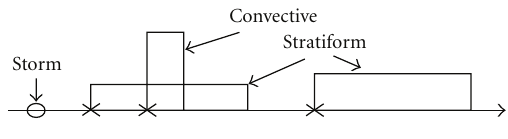
Figure 2: Two types of